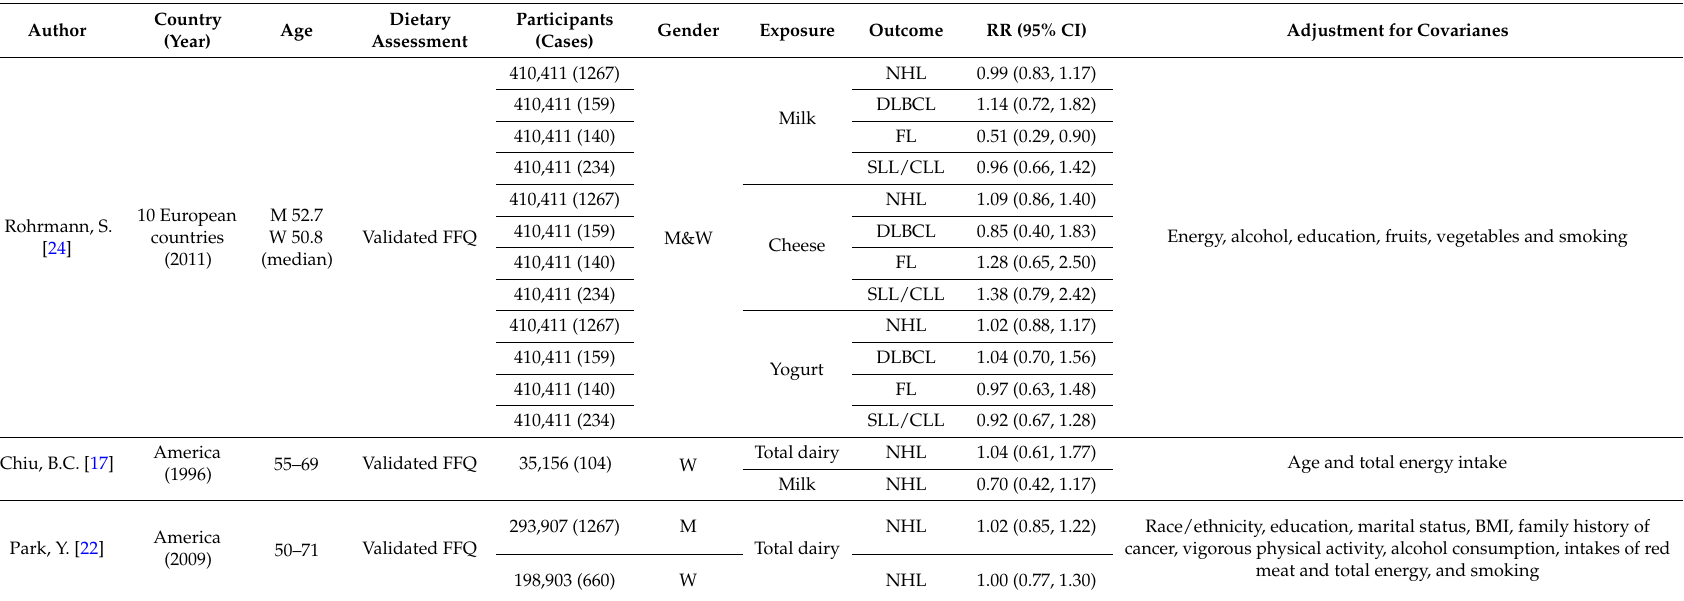
Table 2. Characteristics of cohort studies on dairy product consumption and the risk of